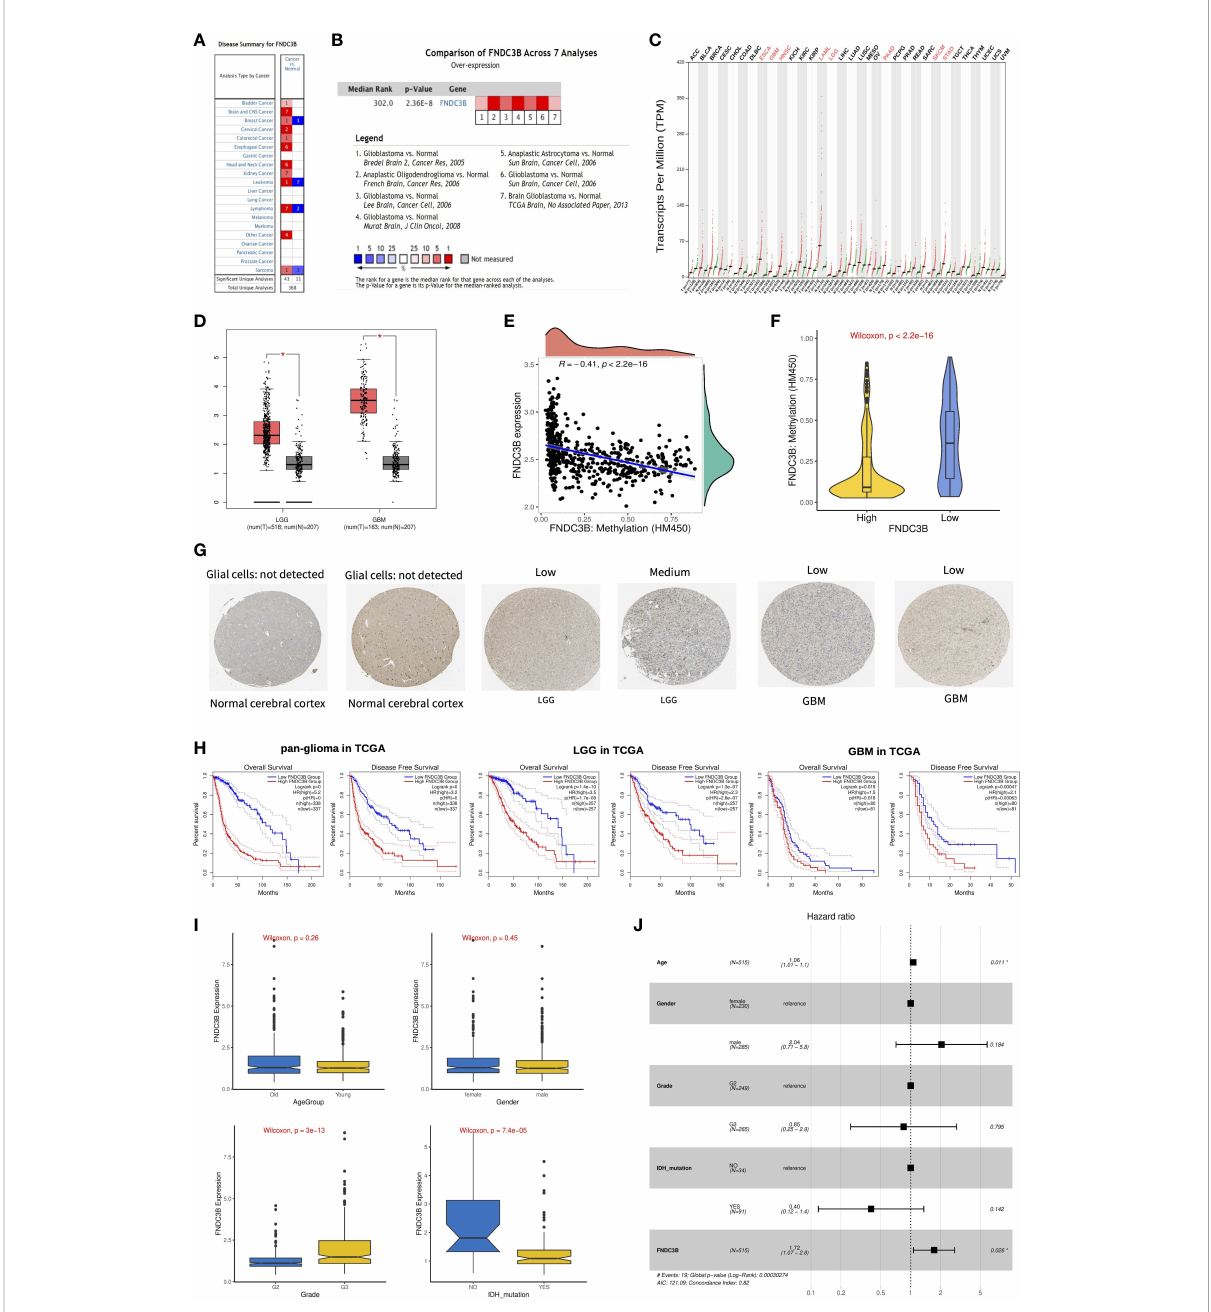
FIGURE 2 The expression pro fi les and prognostic value of FNDC3B in glioma. (A) In brain and CNS cancers, FNDC3B was signi fi cantly upregulated in seven studies. Red represents high expression and blue represents low expression. The darker the red color, the higher the gene expression level. The darker the blue color, the lower the gene expression level. (B) Comparison of FNDC3B expression across seven analyses, and red represents high expression. (C) FNDC3B was signi fi cantly upregulated in various tumors. (D) Expression level of FNDC3B in LGG and GBM compared to control. *, P < 0.05. (E) The expression of FNDC3B was negatively regulated by FNDC3B DNA methylation. (F) Different methylation levels of FNDC3B in the FNDC3B high- and low-expression groups in TCGA LGG samples. (G) Representative FNDC3B protein expression in normal and glioma tissues. Data were obtained from the Human Protein Atlas (HPA). (H) Kaplan-Meier analysis of OS and DFS based on FNDC3B high- vs. low-expression in pan-glioma, LGG, and GBM patients in the TCGA dataset. Red curve represents patients with high expression of FNDC3B, and blue curve represents low FNDC3B. (I) The correlations between FNDC3B expression and clinical characteristics based on TCGA LGG datasets: age, gender, grade, and isocitrate dehydrogenase (IDH) status. (J) Multiple Cox regression analysis of clinicopathological features (including FNDC3B expression) and OS in the TCGA LGG